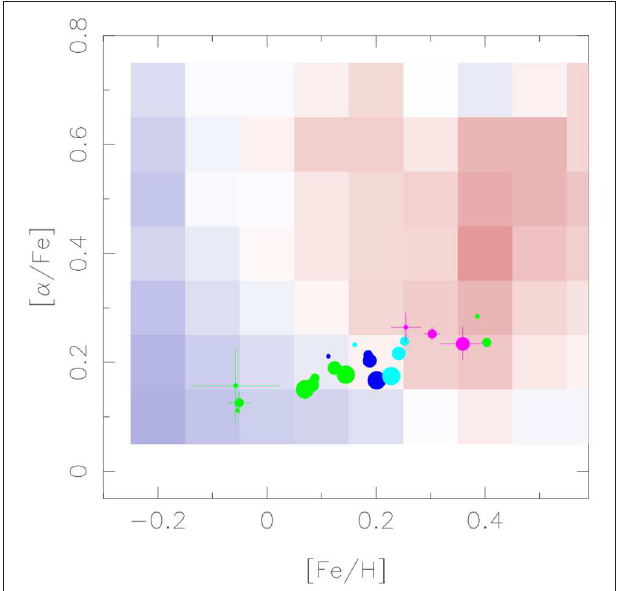
FIGURE 7 | Location of 6dFGS galaxies in the metallicity, α -richness plane. The giant/dwarf red/blue σ color coding is that of the previous figure. Symbols are also sized by surface brightness as in the previous figure, but the intermediate σ bins are color coordinated, rather than connected. Green < 150 km/s; blue is 150–250 km/s; aqua is 250–350 km/s; pink > 350 km/s. At a given σ α -richness tends to anti-correlate with metallicity. More colors are needed to distinguish the four green constant σ bins, which show the same effect, but this is not apparent, as they are all green.